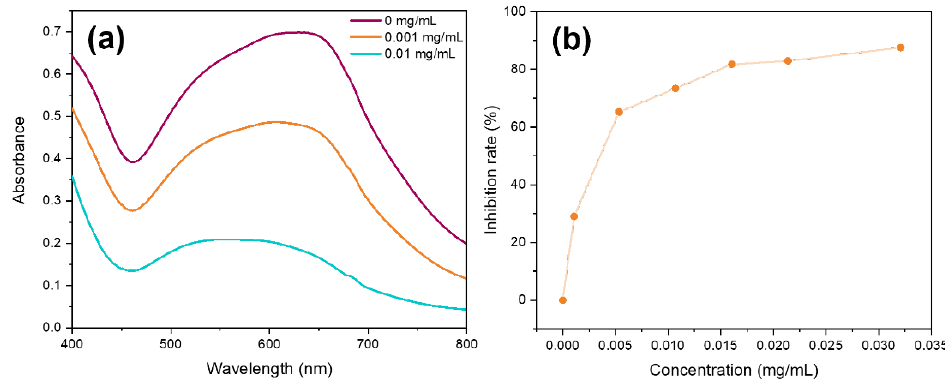
Figure 10. ( a ) UV-visible absorption spectra of different concentrations of Mn-Nanozyme in the superoxide dismutase assay; ( b ) Inhibition rate percentages of superoxide radicals against the concentration of the Mn-Nanozyme.